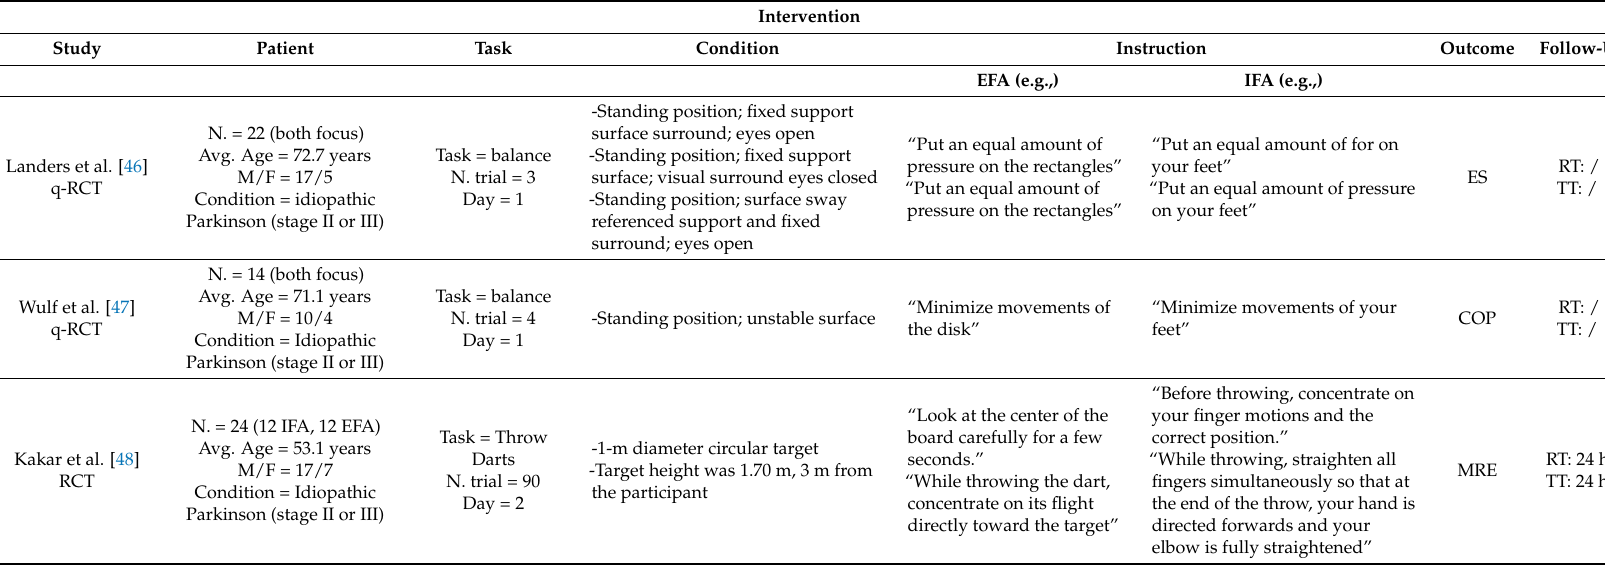
Table A3. Characteristics of the studies regarding patients with Idiopathic